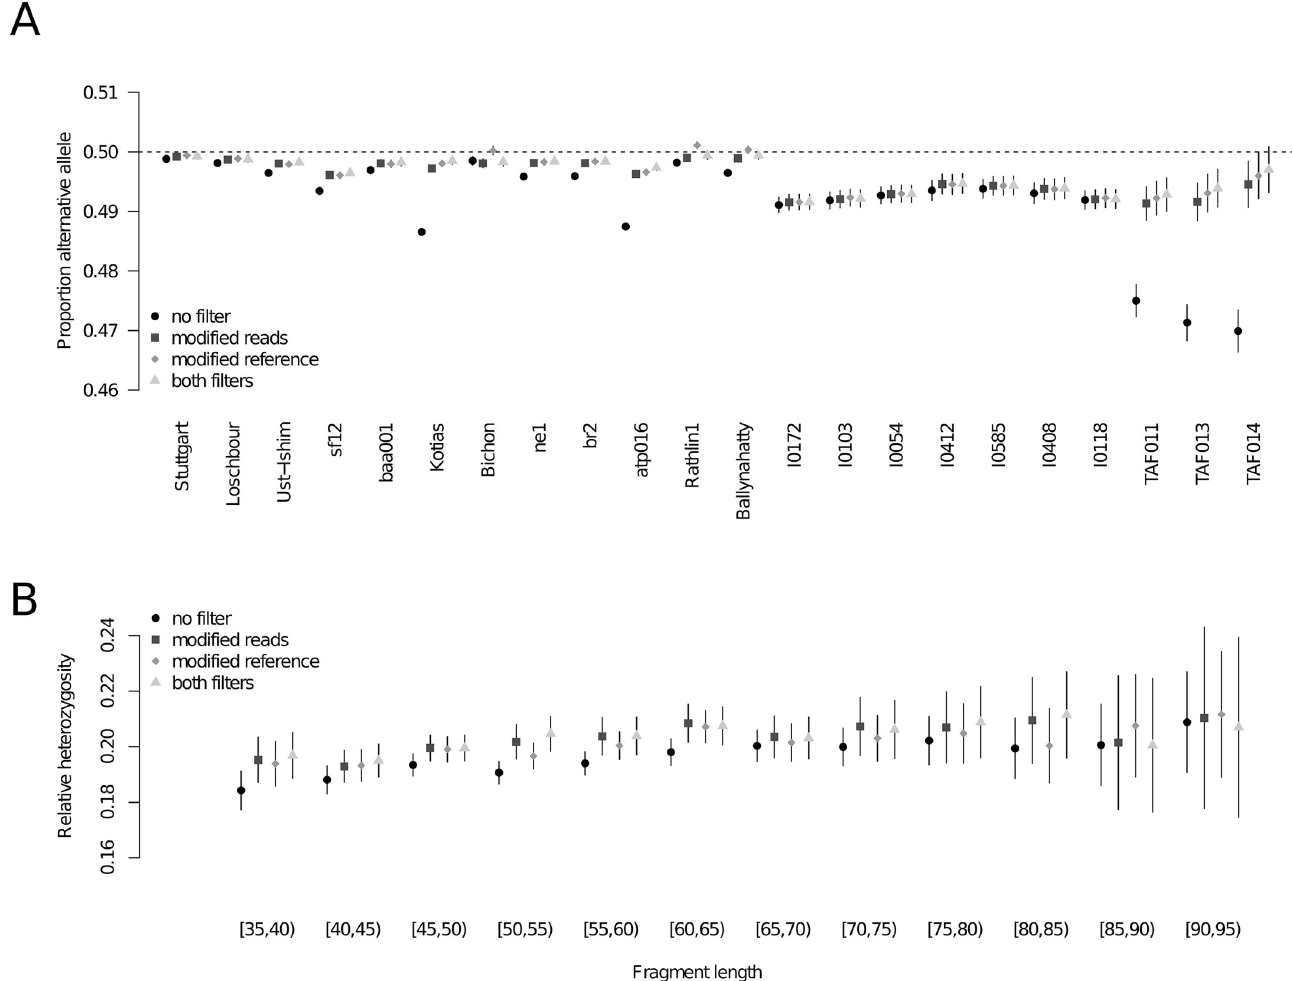
Fig 5. Comparison of different post-mapping filtering strategies for high coverage bam files from anatomically modern humans employing mapping and base quality filters of 30. (A) Average proportion of the alternative allele for the comparison between no additional filters (see also Fig 1), remapping of reads carrying the reference allele modified to carry the alternative allele (modified reads), remapping against a modified reference carrying a third allele at the SNP sites, and both filters together. (B) Influence of filtering on measures of heterozygosity for different fragment sizes in sf12. Error bars indicate two standard errors.